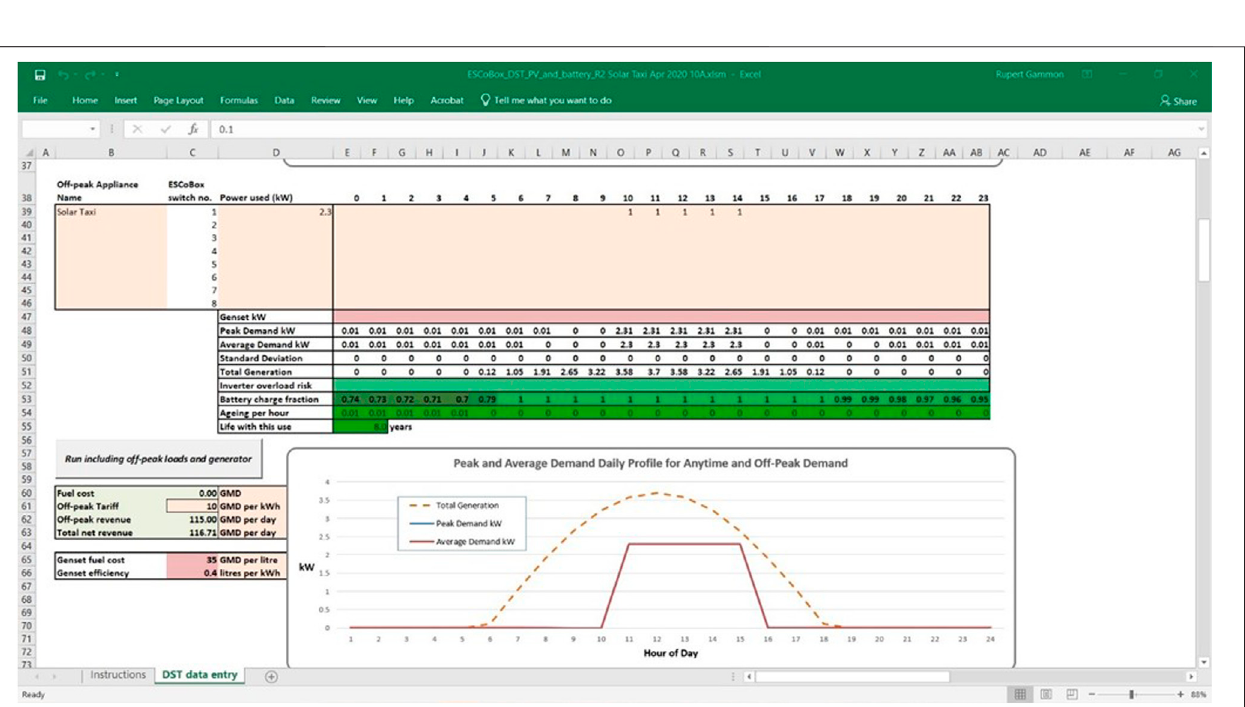
FIGURE 7 | Screenshot of 10 A solar recharging scenario from the ESCoBox decision support tool.